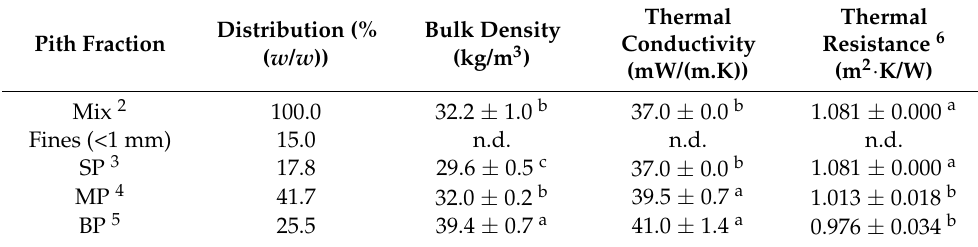
Table 4. Particle size distribution of the amaranth pith particles, and bulk density, thermal conductiv- ity and thermal resistance in bulk at 25 ◦ C of all pith particles (mix) and the SP, MP, and BP fractions generated after sieving 1